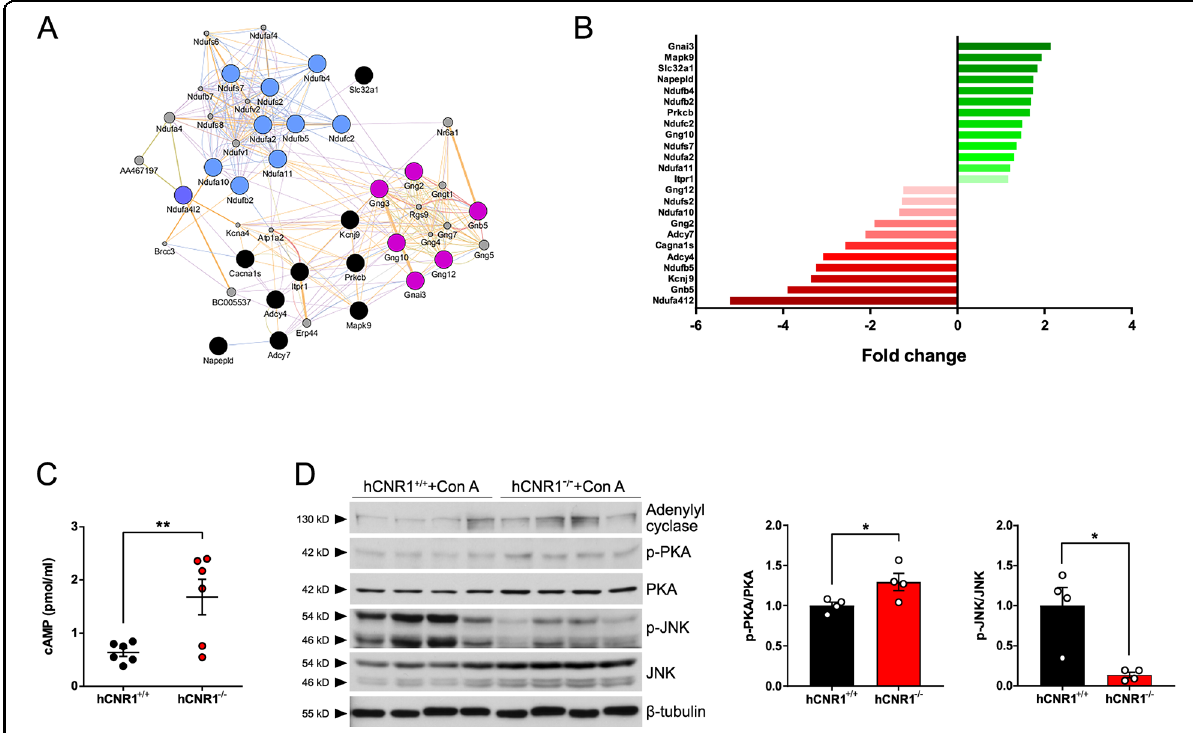
Fig. 4 Ablation of hepatic CB1R plays a critical role in cAMP-dependent pathway to rescue liver damage. A , B Gene network of interactions between the 25 (of 139) signi fi cant genes ( p < 0.05) involved in cannabinoid signaling pathway and their fold change in expression. C cAMP levels (pmol/mg) in liver. D Liver lysates were prepared and protein expression levels are expressed as a ratio of p-PKA/PKA and ratio of p-JNK/JNK (* p ≤ 0.05, ** p ≤ 0.01 compared to hCNR1 + / +